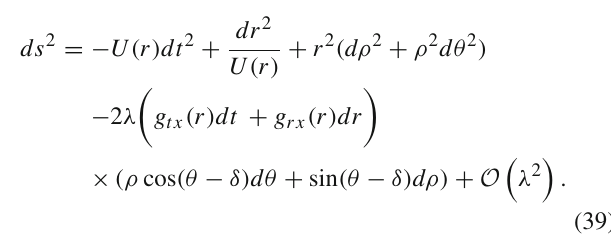
Fig. 5 Cartoons for a minimal surface ( a ) and its top view ( b ) : We regard the wedge type minimal surface as a part of a larger structure, such as a tail of a strip type minimal surface. We have depicted that imagination in the top view ( b )